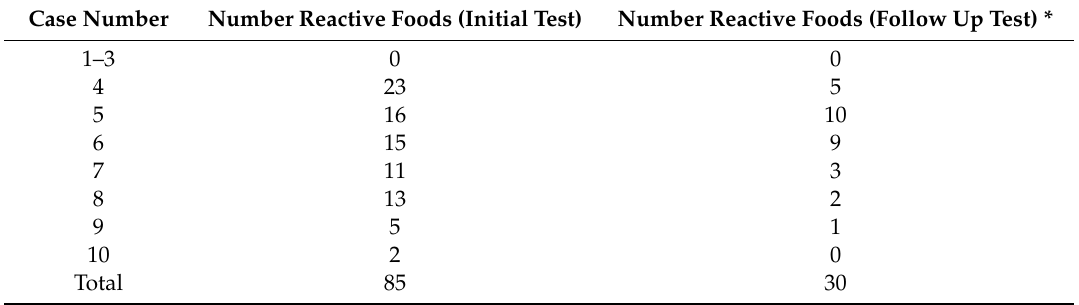
Table 4. Outcome of 10